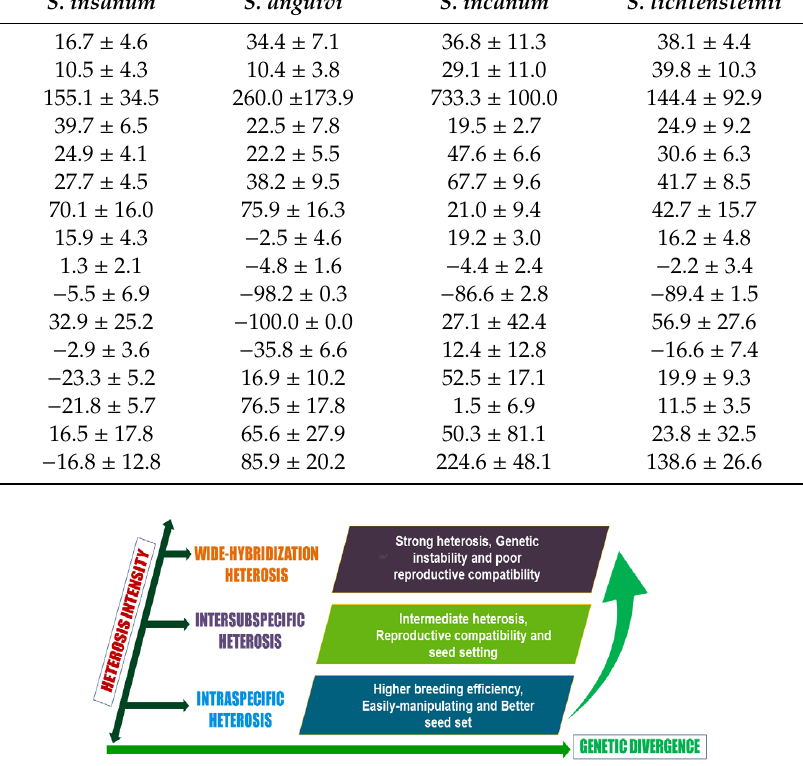
Figure 1. Classification and Features of heterosis exploitation. Table 1. Heterosis in the eggplant using wild relatives as the male parents taken from Kaushik et al. [35,37].